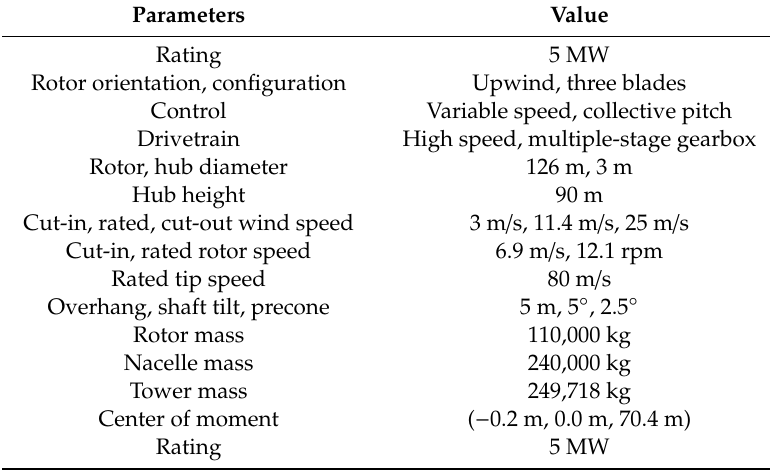
Figure 1. Normalized mode shapes: ( a ) tower fore-aft; ( b ) tower side-to-side; ( c ) blades flapwise and edgewise mode. Table 1. General properties of the National Renewable Energy Laboratory (NREL) 5 MW baseline wind turbine.